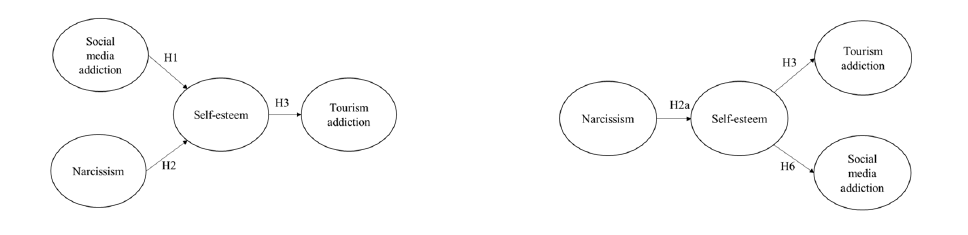
Fig. 1. The Proposed Research